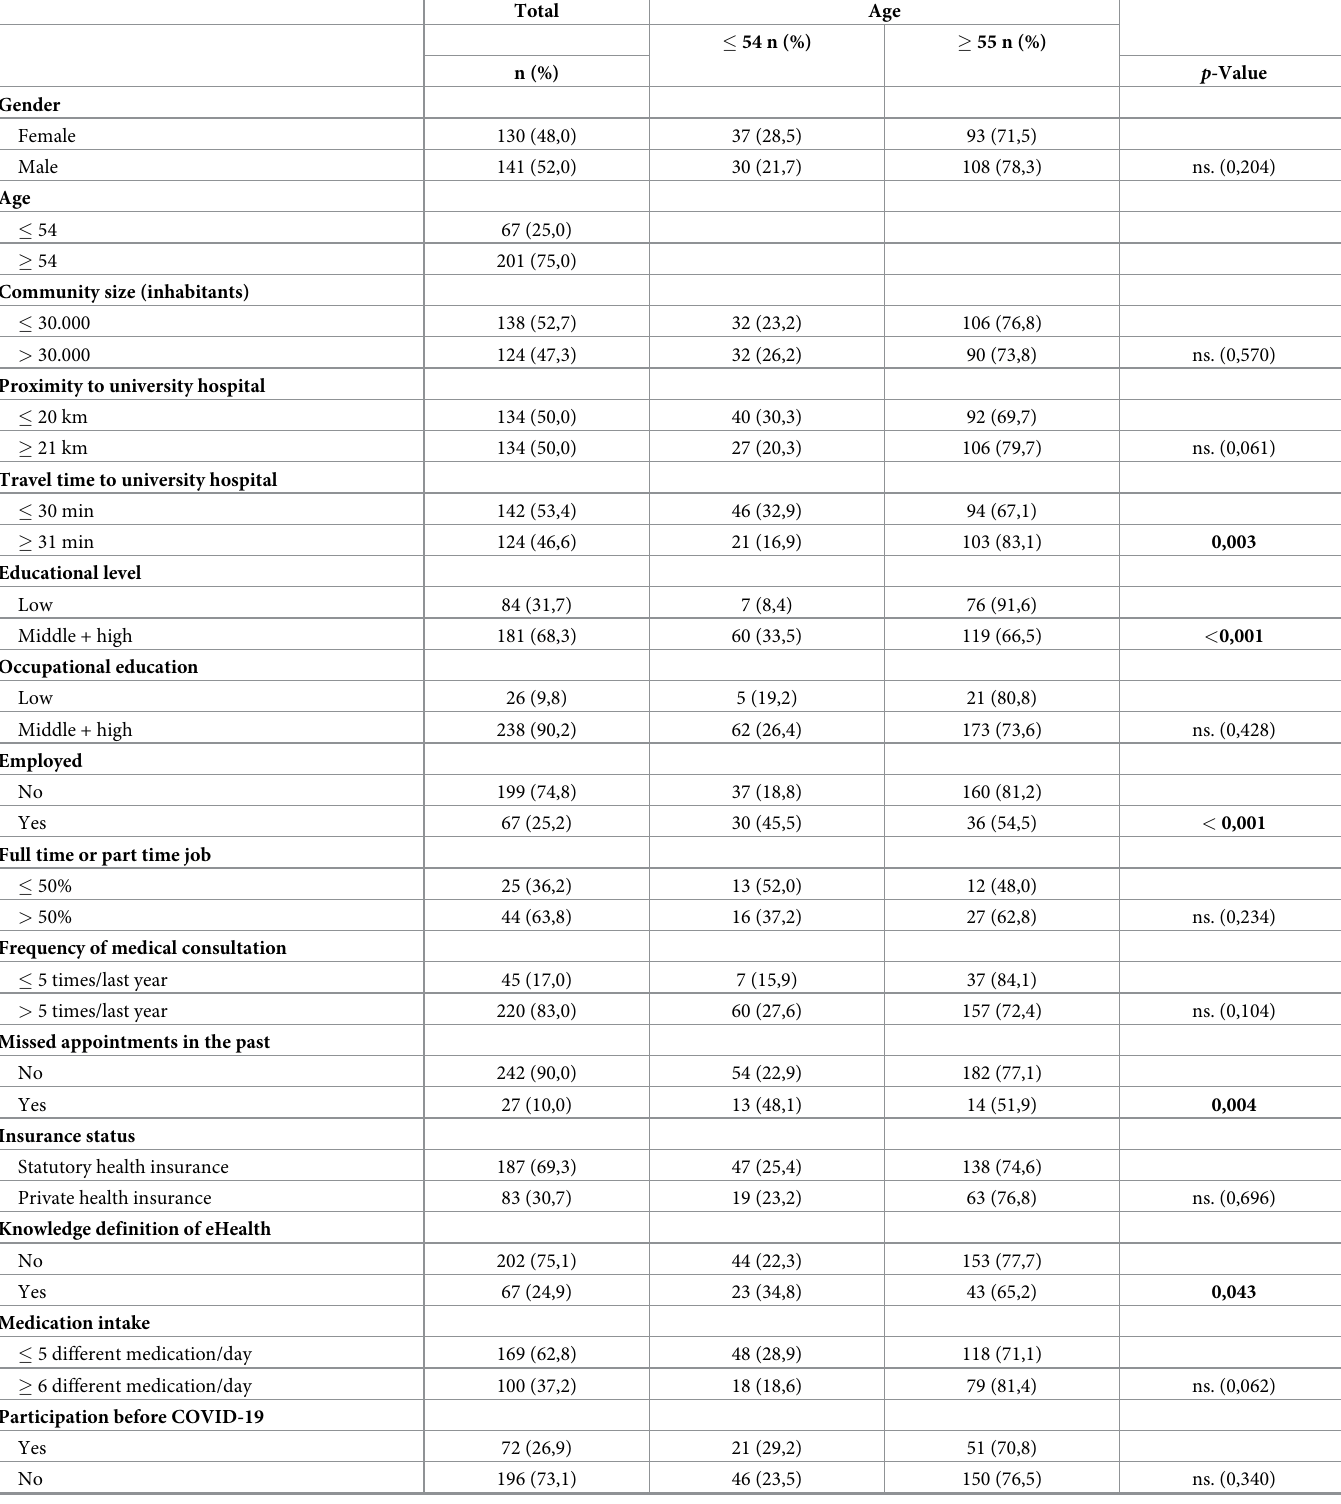
Table 1. Age-related characteristics of the study sample (N =